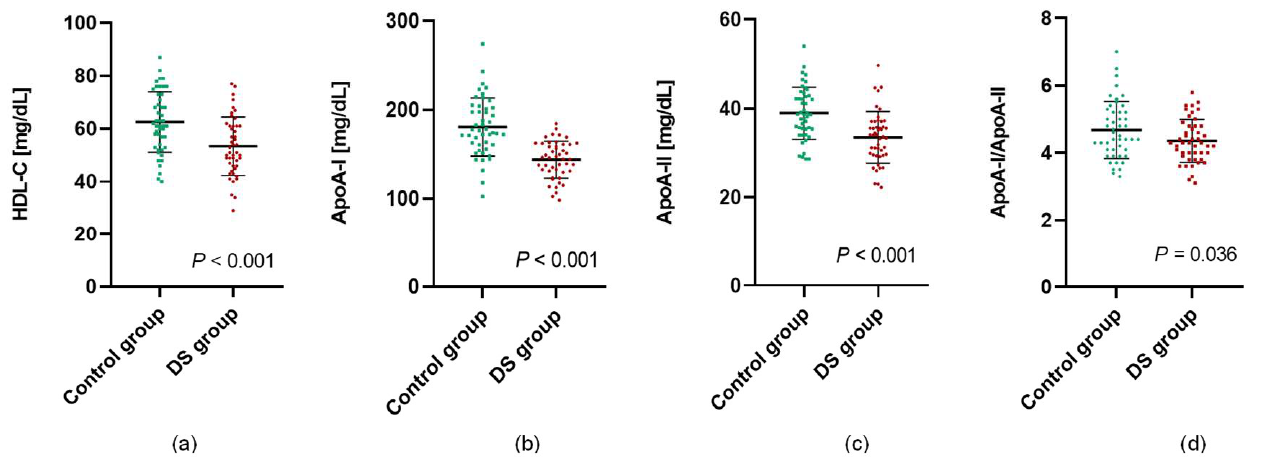
Figure 2. Concentrations of HDL ( a ), ApoA-I ( b ), ApoA-II ( c ), and ApoA-I/ApoA-II ratio ( d ) in patients with Down syndrome (DS group) and patients without Down syndrome (control group). Values are presented as mean ± standard deviation and were assessed using Student’s t -test.